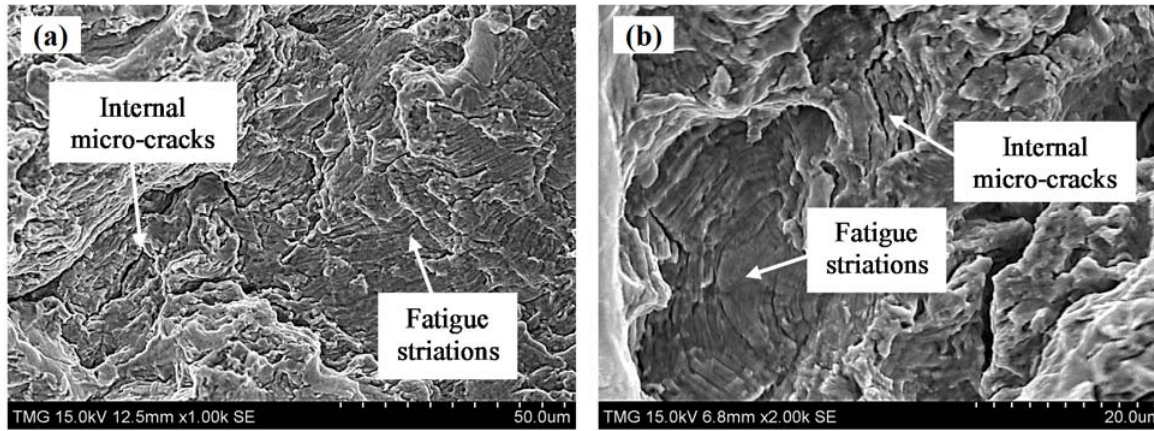
Figure 24. Fatigue striations in ( a ) non-treated Ti64; ( b ) DR-treated Ti64